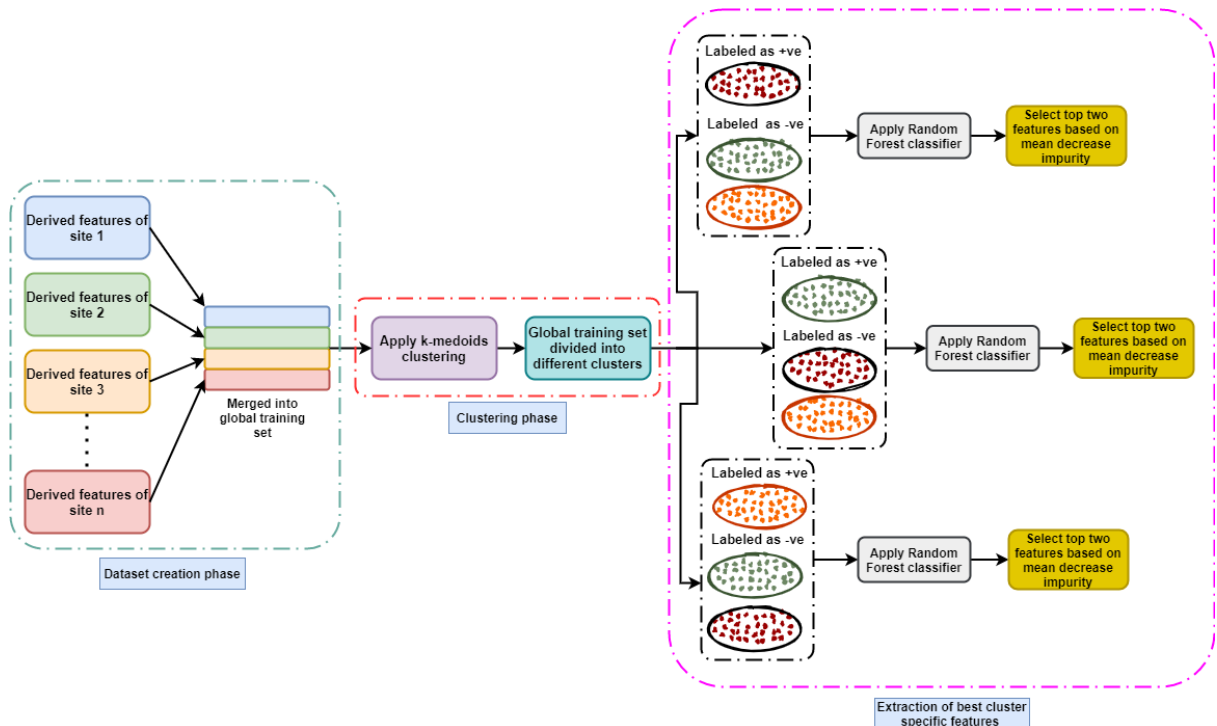
Figure 6. Cluster-specific best feature identification strategy.